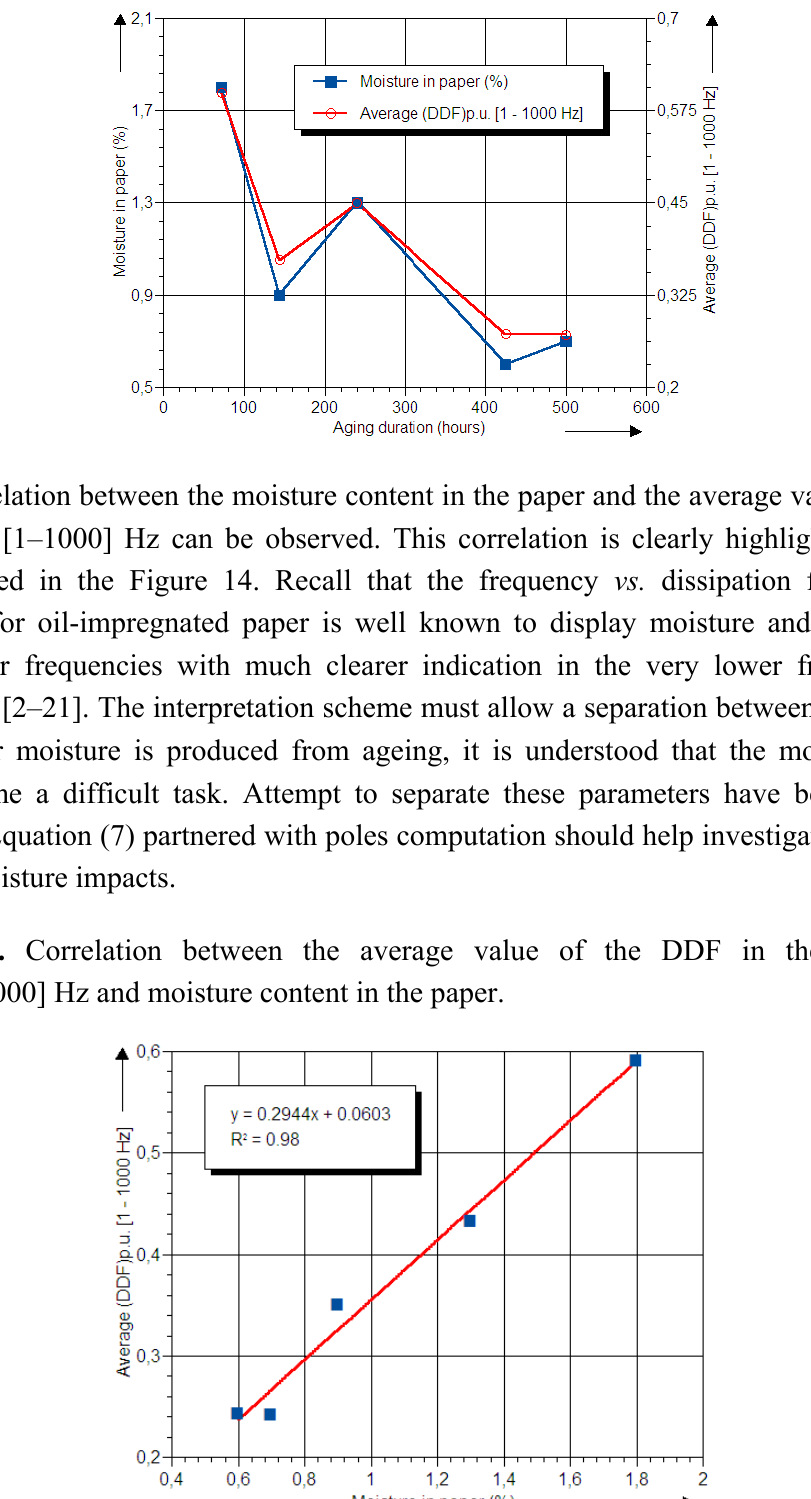
Figure 13. Average value of DDF in the frequency range [1–1000] Hz and moisture content in the paper as a function of the ageing duration.